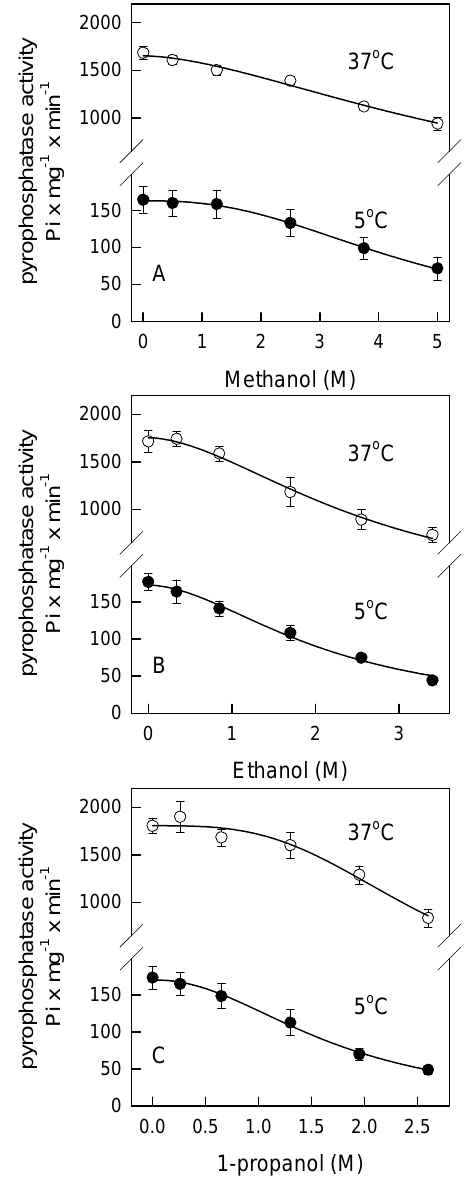
Fig. 1 – Inactivation of yeast inorganic pyrophosphatase by alco- hols. Reaction was performed as described under Materials and Methods at 5 ◦ C ( • ) and 37 ◦ C ( ◦ ) in the presence of the concen- trations of methanol (panelA), ethanol (panel B) and 1-propanol (panel C) indicated on abscissa. Data points represent means ± SE of four independent experiments (n = 4). Lines are calcu- lated adjusting the parameters of equation 1 to the experimental